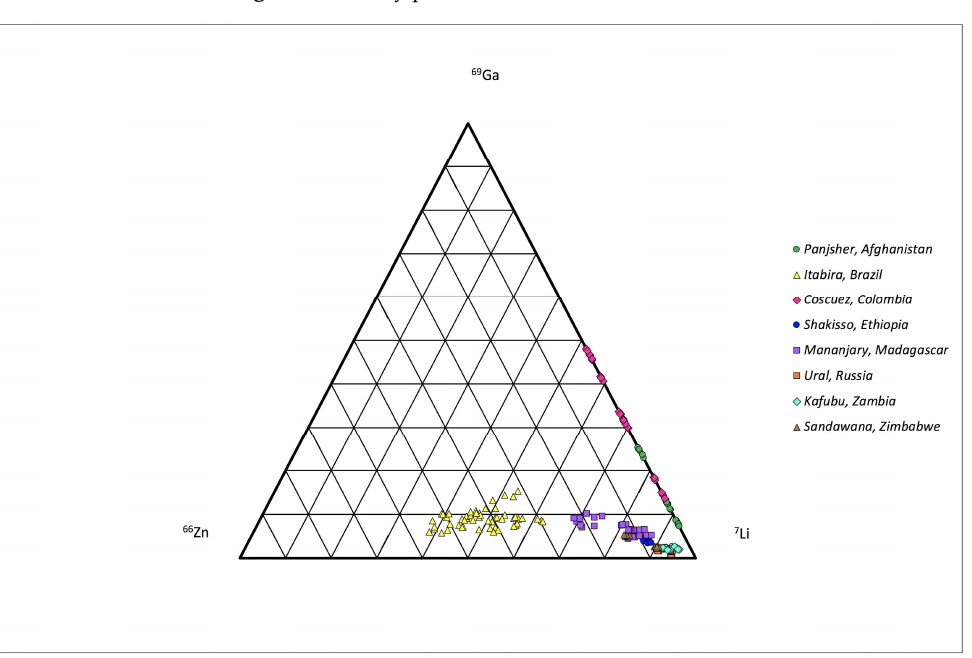
Figure 12. Ternary plot of 66 Zn vs. 69 Ga vs. 7